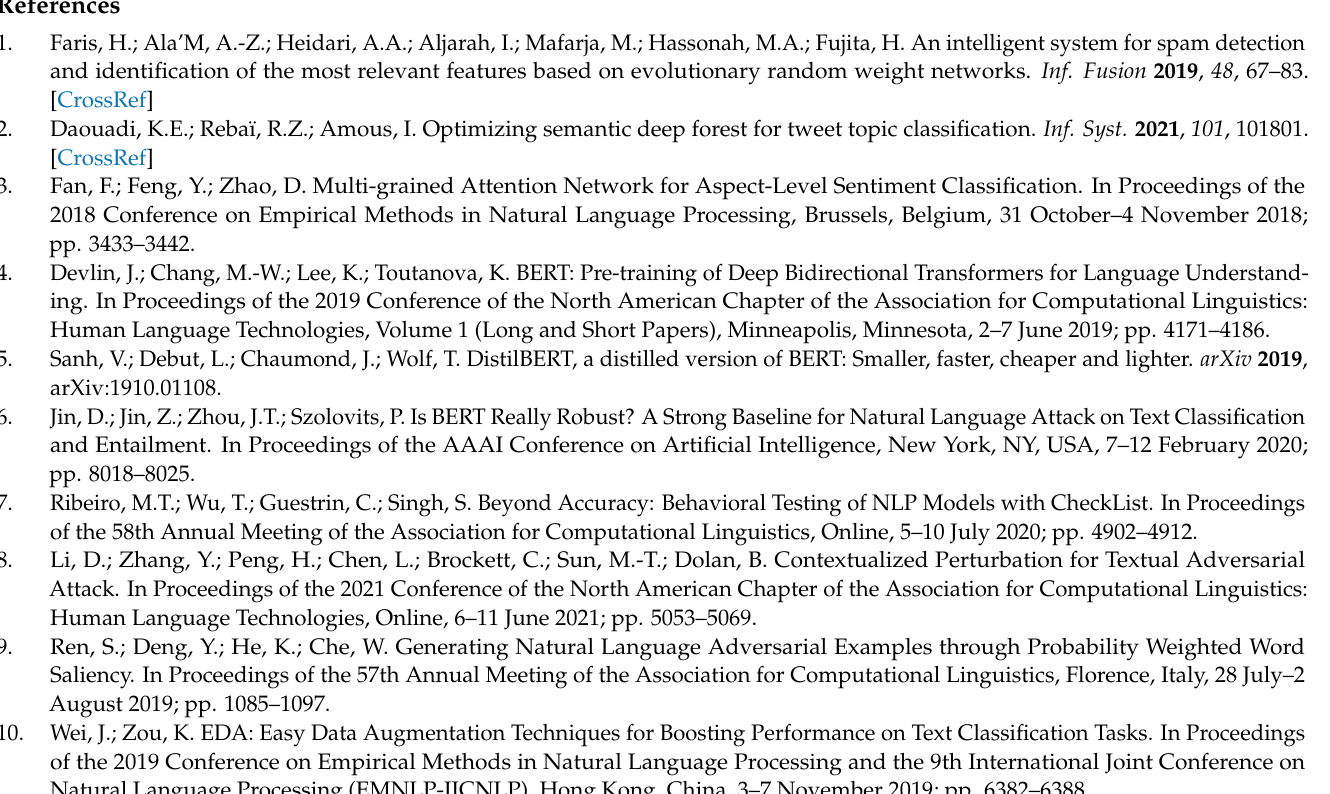
Figure A5. Antipode3 Run3 Confusion Matrix on TREC.